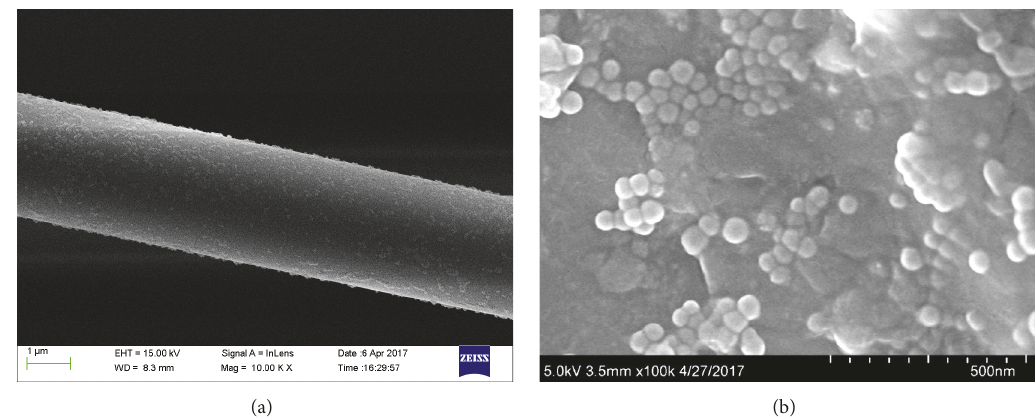
Figure 4: Surface morphology of the OMF with HSNs (a) at 15kv and 10k × and (b) at 5kv and 100k × .